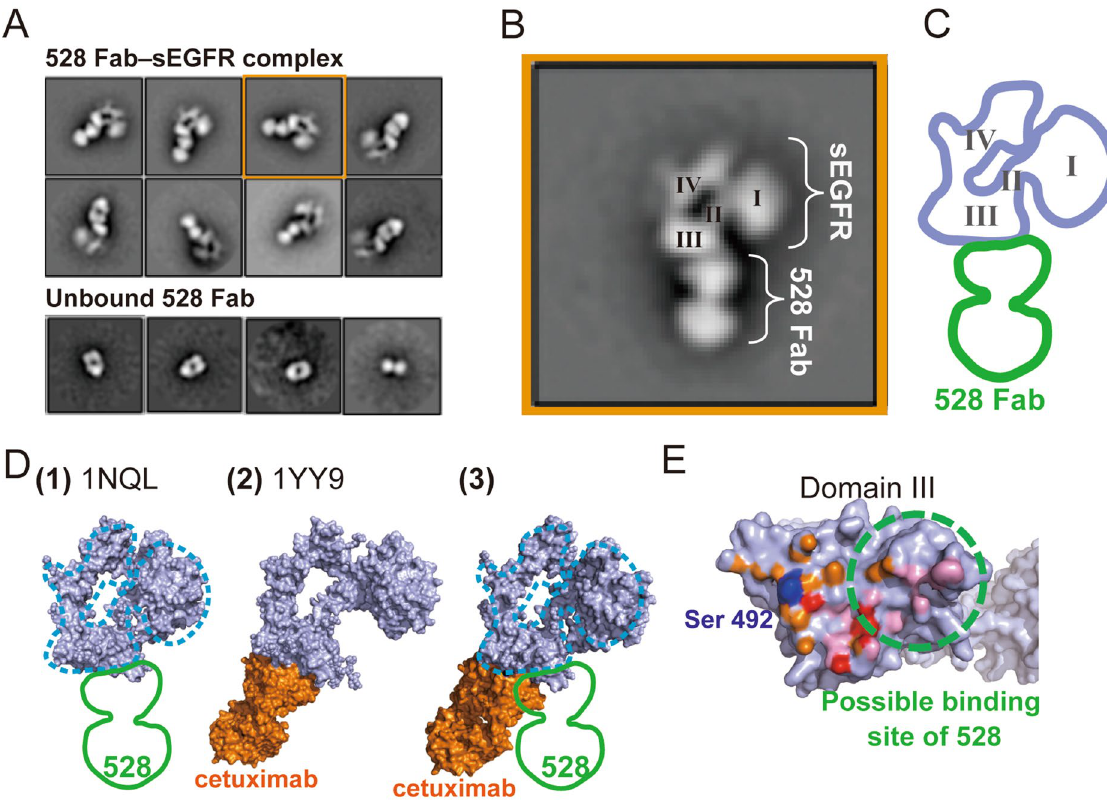
Figure 2. Negative-staining electron microscopy of the 528 Fab–sEGFR complex. ( A ) Two-dimensional (2D) class averages of the negatively stained 528 Fab–sEGFR complex. The purified complex was subjected to single particle image analysis via negative-staining electron microscopy. Upper panel: representative 2D class averages of the 528 Fab–sEGFR complex in their different orientation classes. Lower panel: dissociated 528 Fab. ( B ) Magnified representation of a 2D class average shown in ( A ) (orange square in ( A ), 90° rotated). Four domains of sEGFR are labeled. ( C ) An outline trace of the averaged image of ( B ) the sEGFR portion is shown in light purple and the 528 Fab portion is shown in green. ( D ) (1) A crystal structure of sEGFR (light purple, PDBID: 1NQL) overlapping with the outline trace (blue dashed line: sEGFR, green: 528 Fab). (2) A crystal structure of the cetuximab Fab–sEGFR complex (sEGFR: light purple, Cetuximab: orange, PDBID: 1YY9). (3) Cetuximab Fab onto the 1NQL sEGFR structure by superposing the domain III of both structures. The outline trace is overlapped onto the sEGFR structure (blue dashed line: sEGFR, green: 528 Fab). ( E ) Domain III surface from the view of the cetuximab side. Atoms within 3.5 from cetuximab and EGF are colored with orange (cetuximab), pink (EGF), and red (both). A possible binding area of 528 is indicated with a dashed green circle. Å Ser 492 is shown in